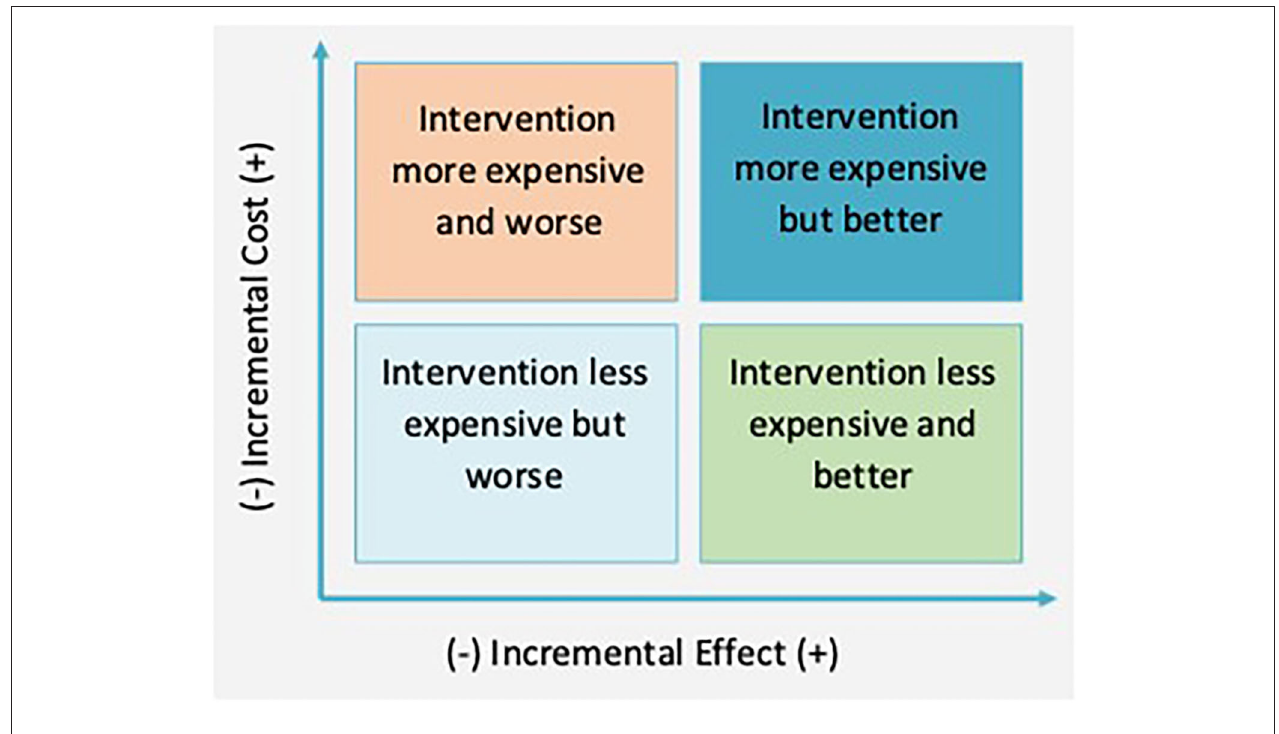
FIGURE 2 | Cost-effectiveness table.